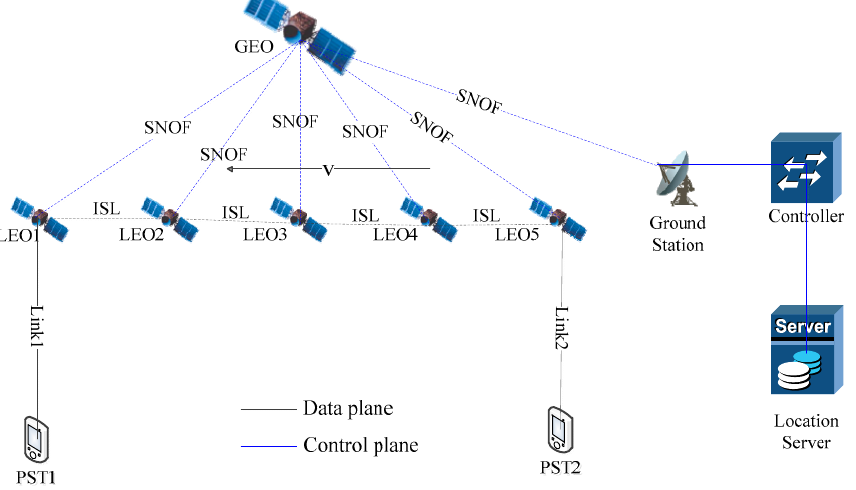
Figure 1. SDSN architecture.